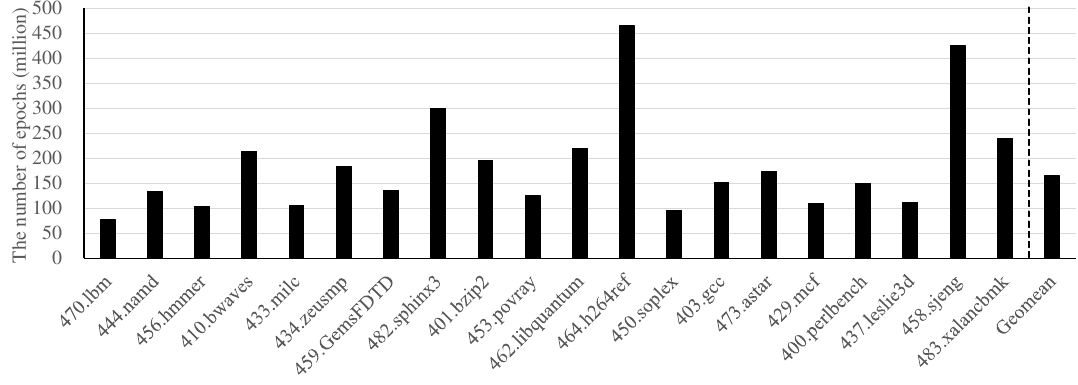
Figure 1. The number of epochs for the SPEC CPU2006 benchmarks